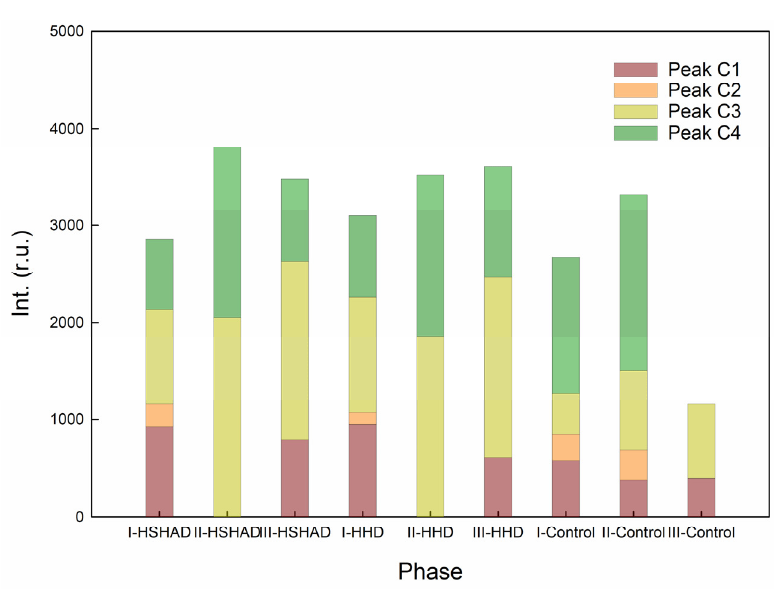
Figure 2. Compositional proportions of di ff erent peak intensities for HSHAD and HHD mesocosms during the operation